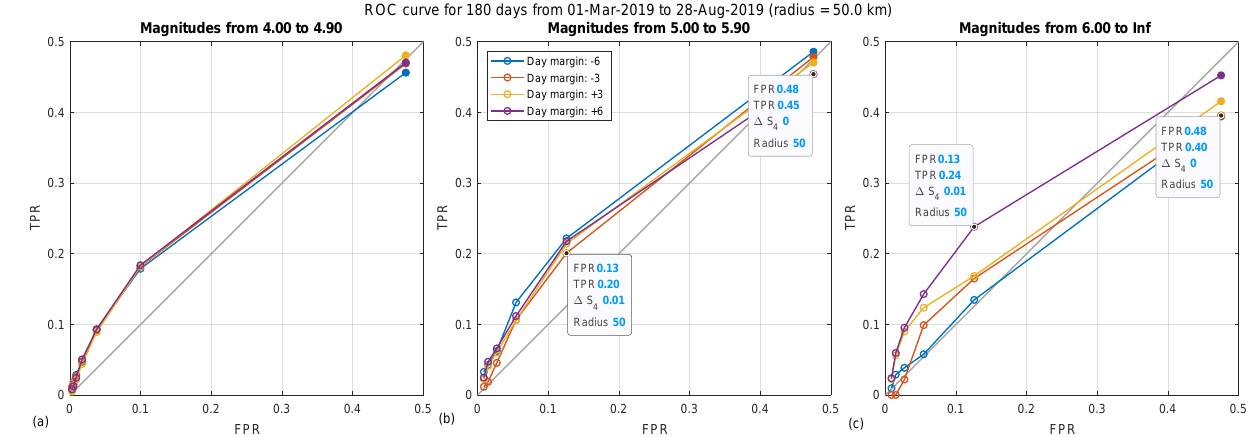
Figure 14. ROC curves for three magnitude intervals using radius = 50 km.